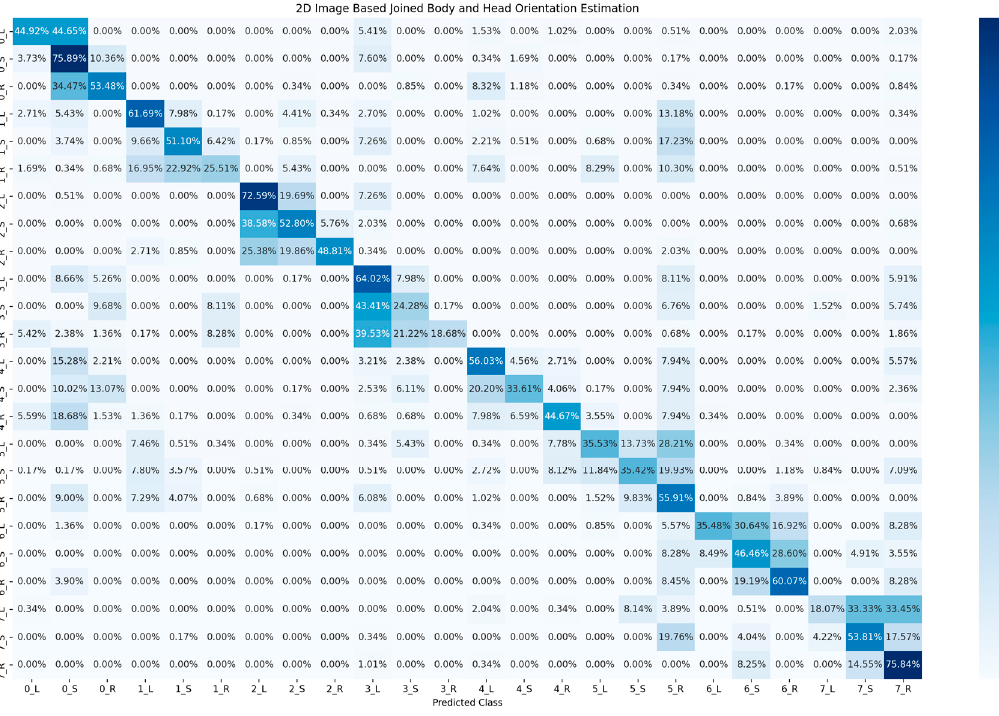
Figure 5. Confusion matrix of cyclist joined body and head orientation estimation using 2D images.